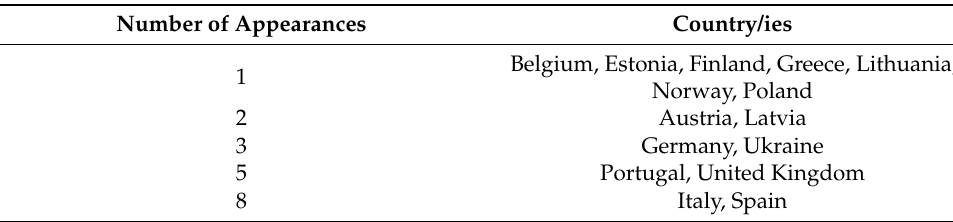
Table 4. Quantification of origin countries in selected articles. Number of